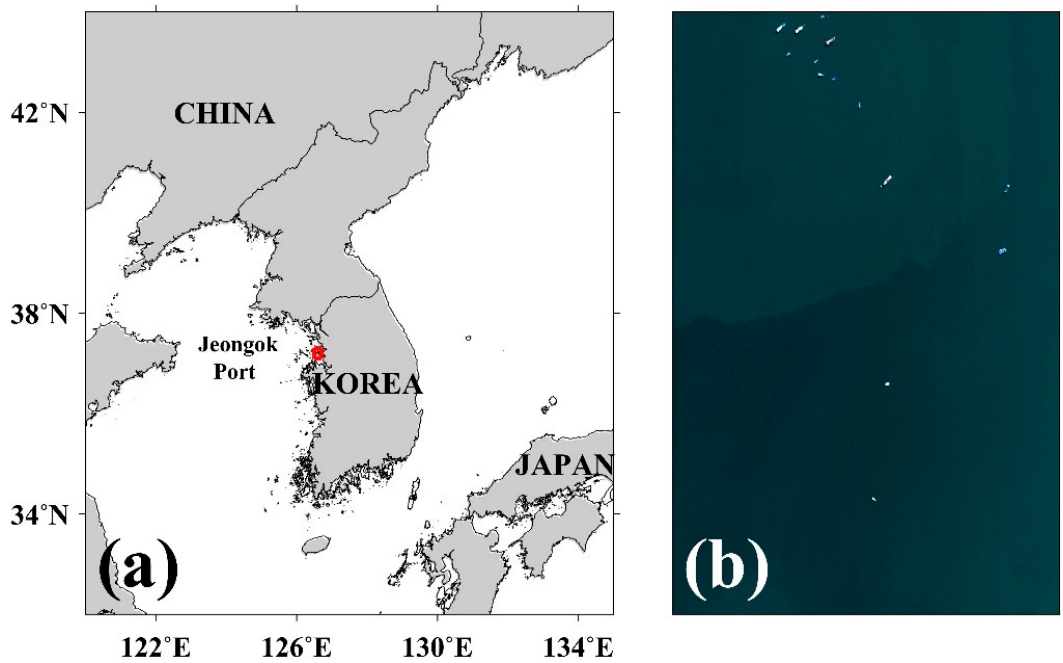
Figure 1. ( a ) Location of the Jeongok Port, ( b ) enlarged portion of the red box in ( a ), RGB hyperspectral image taken on May 10, 2019.